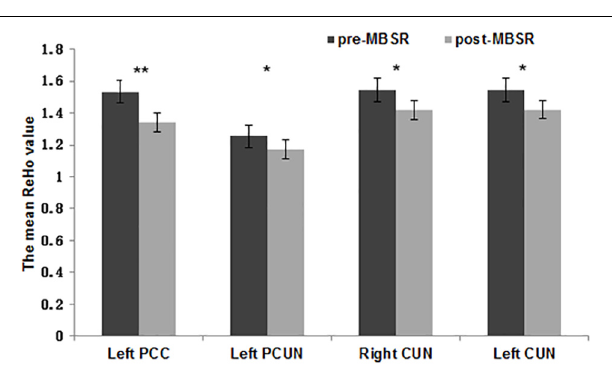
FIGURE 3 | Regional homogeneity values of various regions of interest. The normalized mean regional homogeneity (ReHo) values of regions of interest (ROIs) in the left posterior cingulate cortex (x = –6, y = 52, z = 28), left precuneus ( x = –12, y = –67, z = 34), right cuneus ( x = 9, y = –70, z = 37), and left cuneus ( x = –6, y = –76, z = 34). The error bars indicate the standard error. ∗ p < 0.05, ∗∗ p <